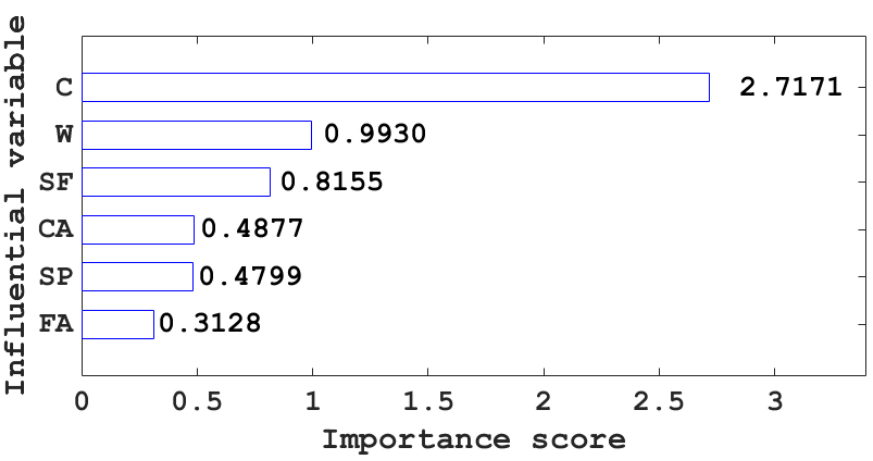
Figure 13. Importance scores of different input variables to the compressive strength of